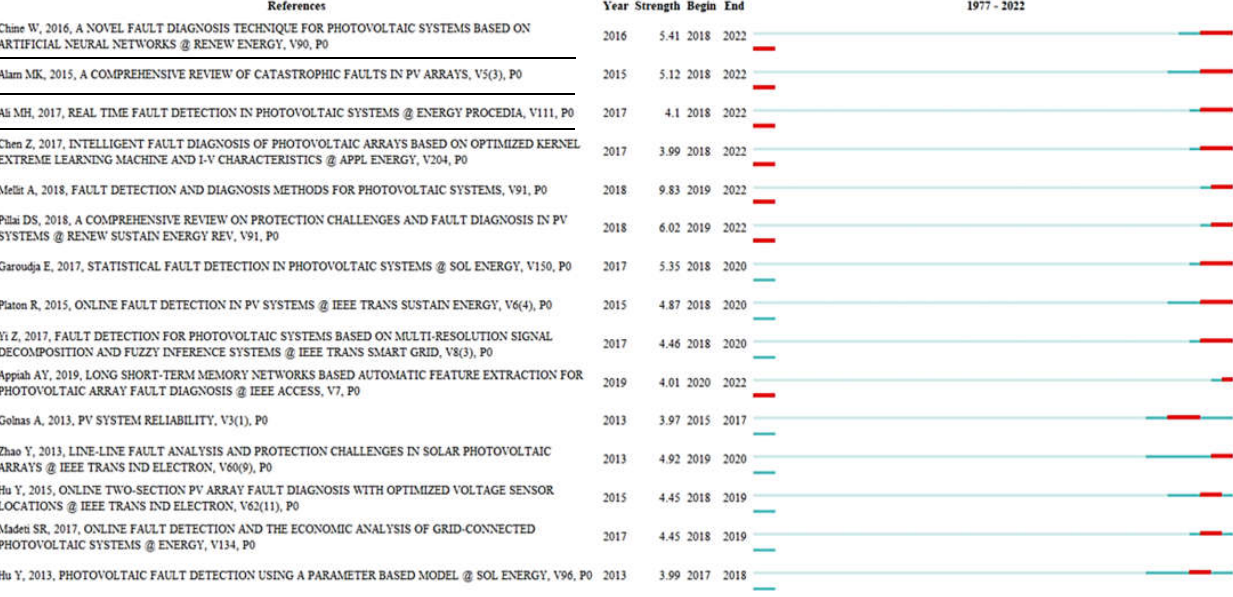
Figure 6. Top fifteen references with strong citation bursts. The underlined references [43–45] are reviewed in the article. reviewed in the